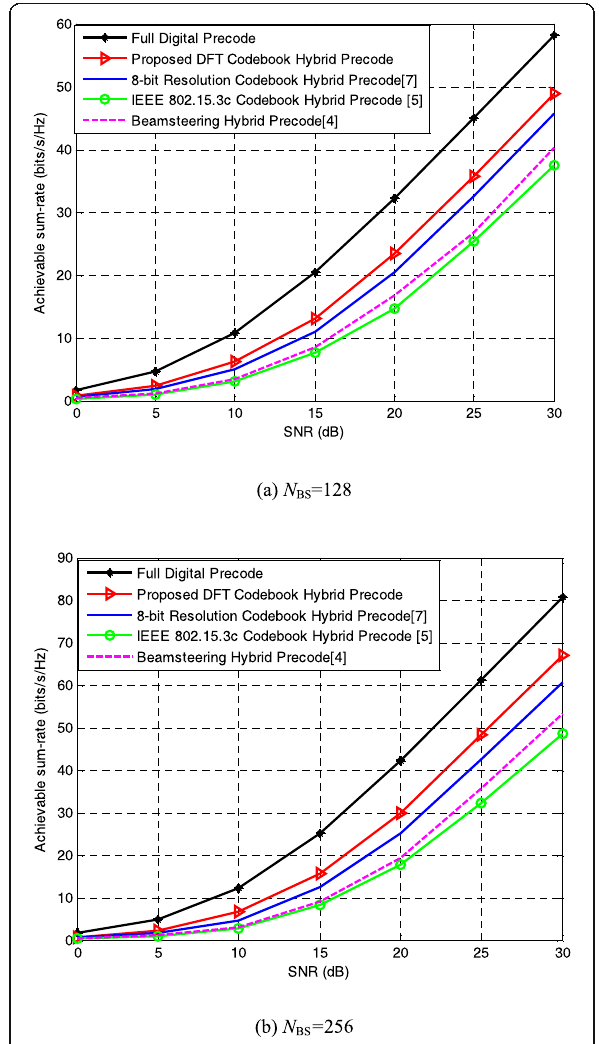
Fig. 4 The achievable sum rate vs. SNR ( U = 4 with 2-antennas ’ MS). a N BS = 128. b N BS = 256 Fig. 5 The achievable sum rate vs. SNR with the number of